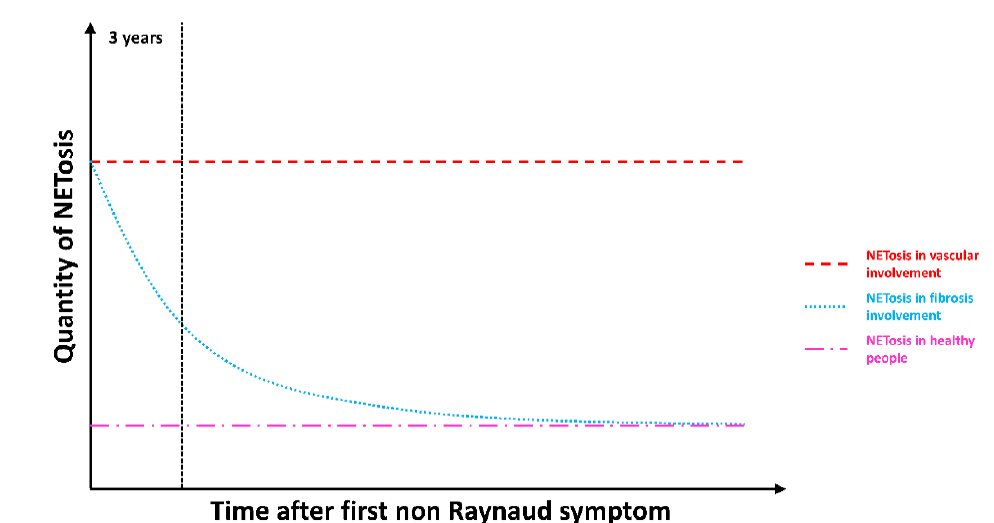
Figure 6. Schematic representation of the quantity of NETs generated by SSc PMN in vitro according to disease duration and the type of complication. The red line represents mean NETosis amount generated by PMN from patients with chronic vascular complications. The blue line represents mean NETosis production by PMN from patients with a predominant fibrotic pattern and no vascular severe complication. The pink line represents mean NETosis production by PMN from healthy subjects.